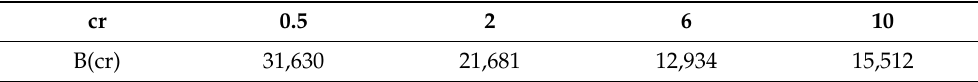
Table 2. Pre-factor related to